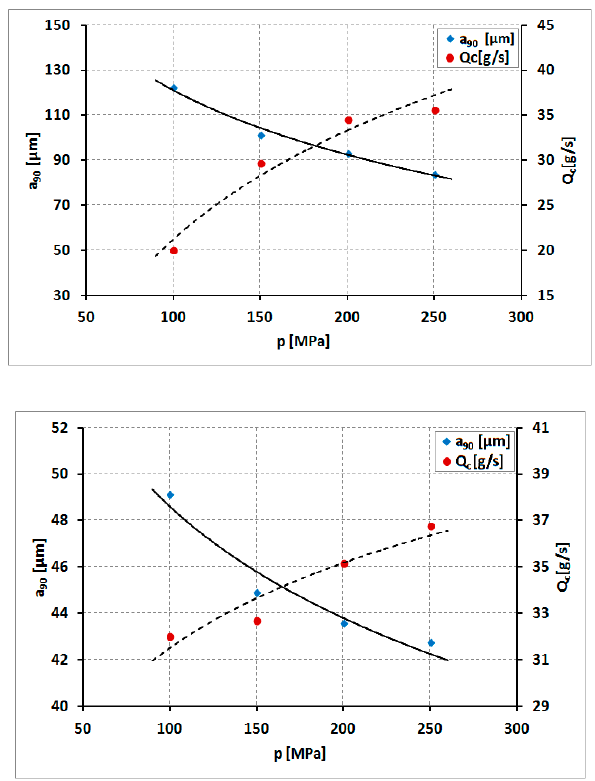
Figure 3. Influence of water jet pressure on the efficiency of the comminution (of characteristic dimensions) for 90% of ground copper ore particles (a 90 ), and the efficiency (Q c ) of its milling process for: ( a )—carbonate, ( b )—sandstone, ( c )—shale ore.